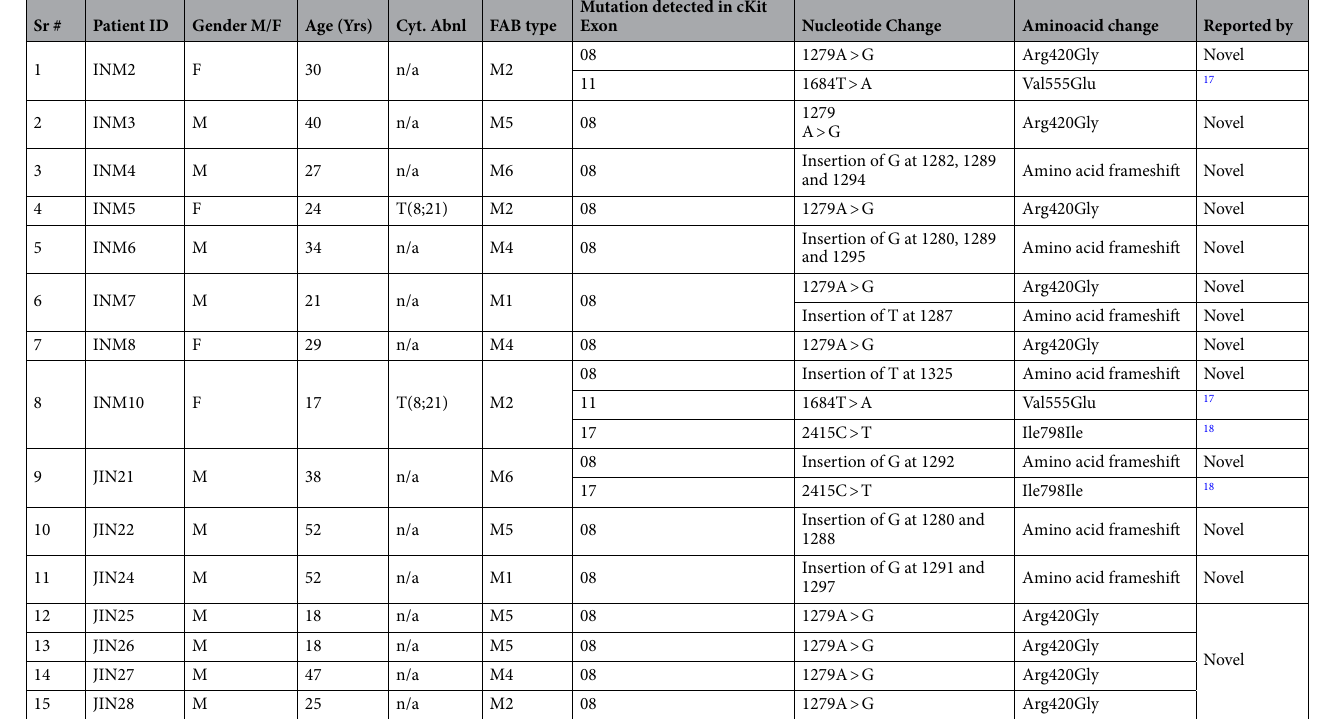
Table 2. C-kit exon 8,11 and 17 mutations detected in the present cohort of Acute myeloid leukemia (n = 31). M Male, F Female, Yrs Years, n/a not any, Cyt.Abnl Cytogenetic abnormality, FAB French American British classification.